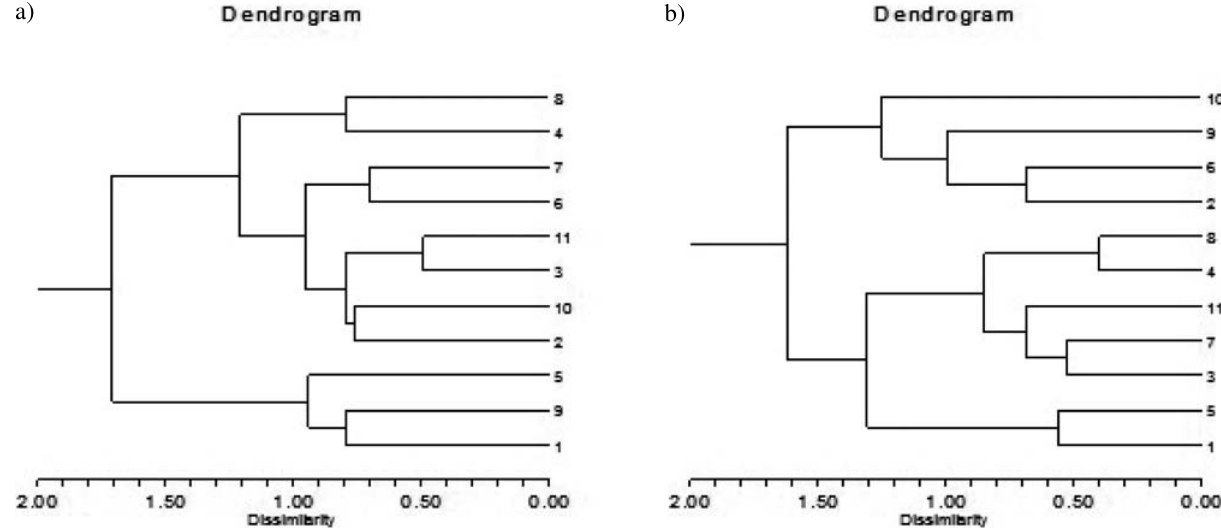
Figure 3. Clustering of examined compounds in the space of molecular (a) and in silico ADME descriptors